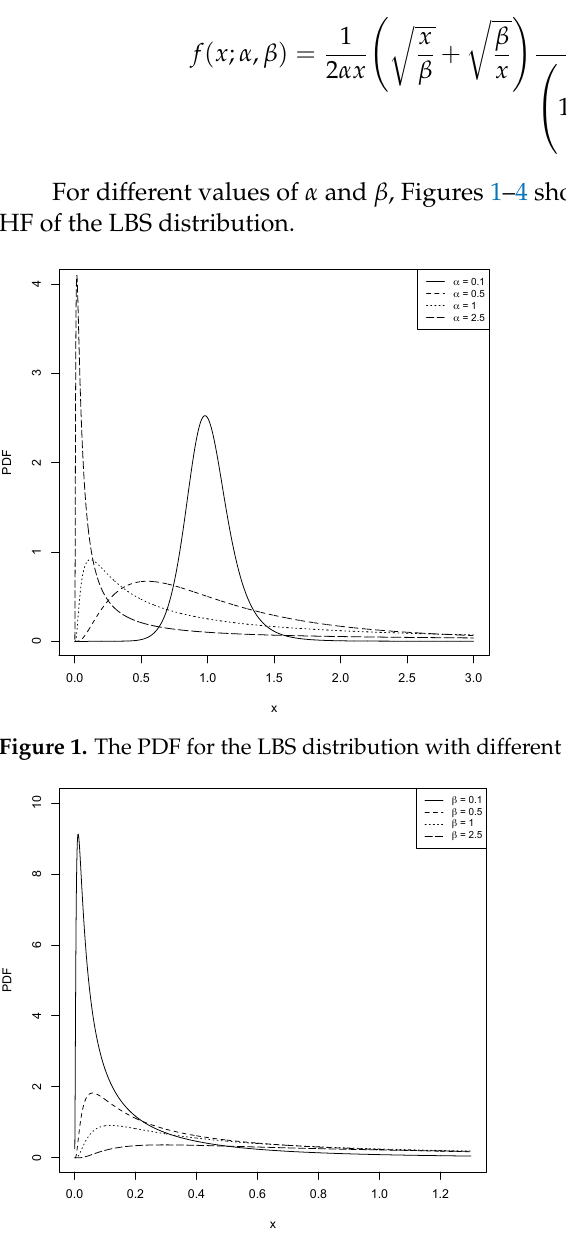
Figure 2. The PDF for the LBS distribution with different values for β and α =